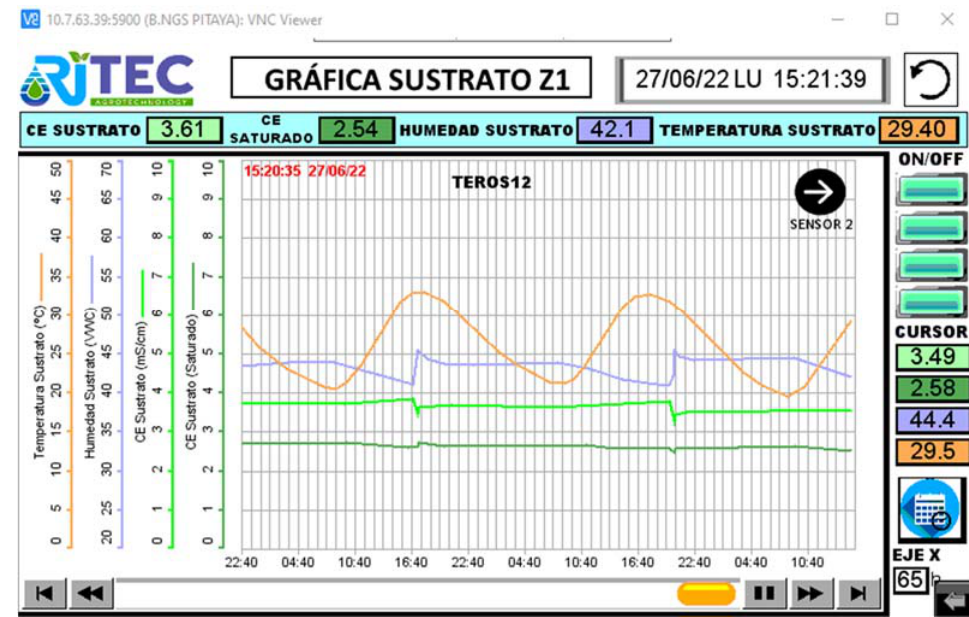
Figure 12. Screenshot of example of output data in the graphic format with substrate temperature, VWC, and EC.